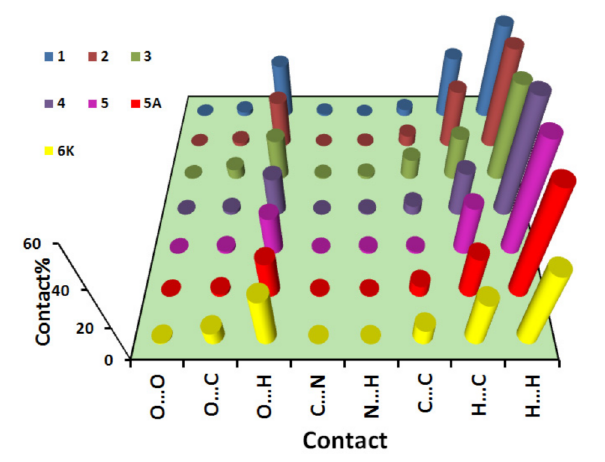
Figure 5. Summary of the intermolecular interactions and their percentages in the crystal structure of the studied compounds. For contact percentages see Table 3.